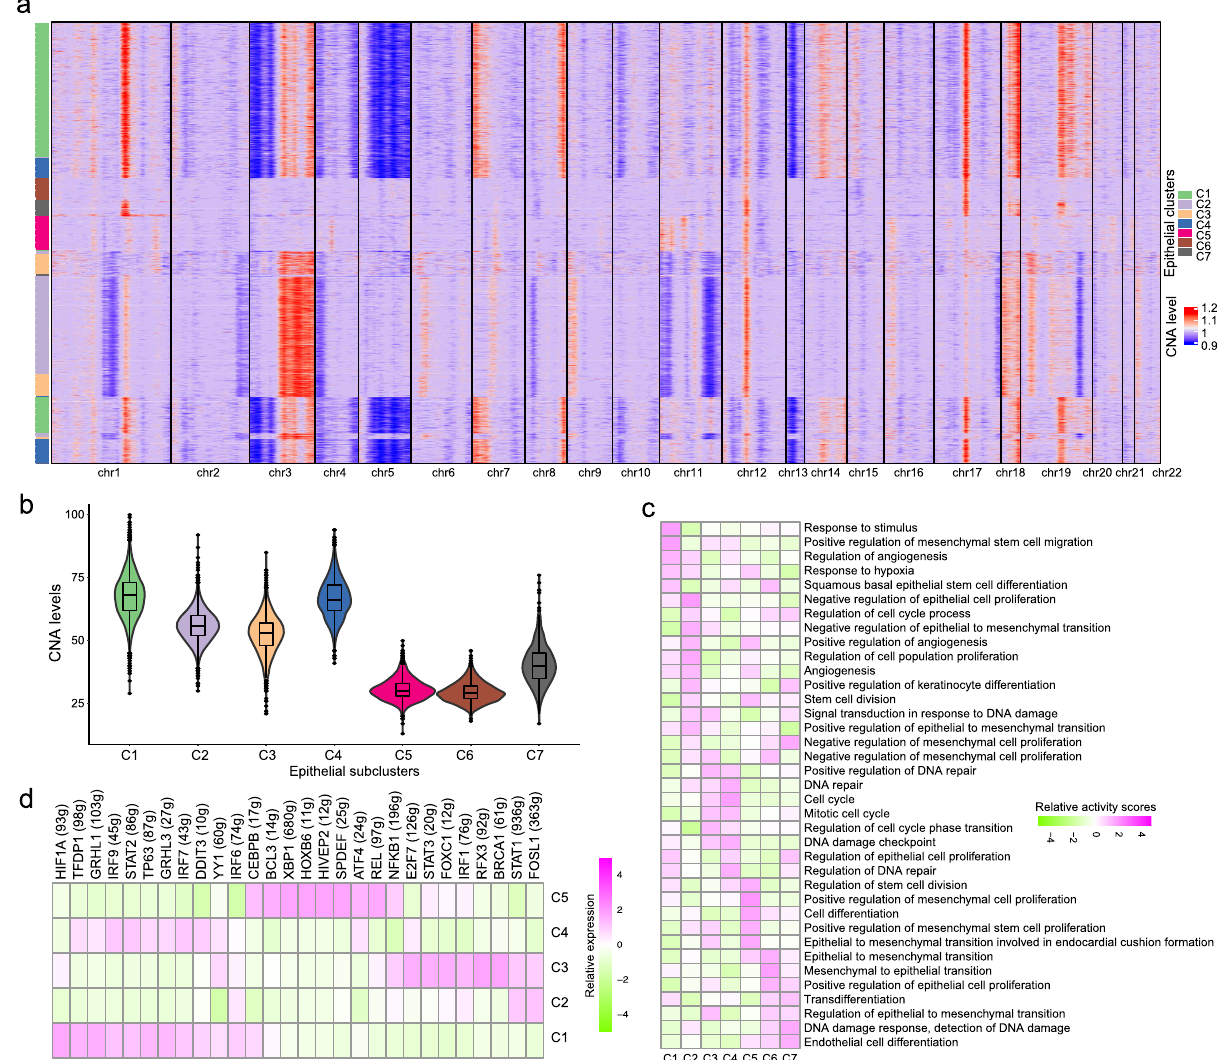
Fig. 2 Molecular differences among epithelial cell subclusters. a Inferred CNA levels in each epithelial cell cluster across 22 chromosomes. b Comparisons of overall CNA levels among different epithelial subclusters. c Heatmap shows the relative activity scores of biological processes in each epithelial subcluster. d Heatmap shows the relative expression of differential transcription factors in each cancer epithelial cell